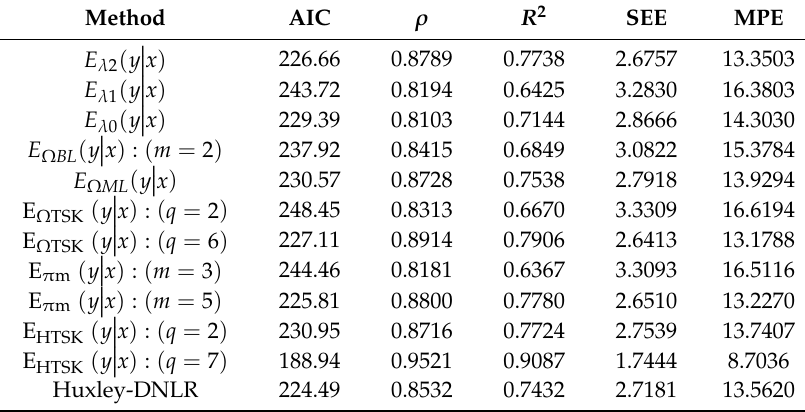
Figure 8. Retransformed biphasic Ω TSK ( u ) (panel ( a )), direct scales fitted biphasic H TSK ( x ) (panel ( b )), Figure 8. Retransformed biphasic 𝛺 (cid:3021)(cid:3020)(cid:3012) (𝑢) (panel ( a )), direct scales fitted biphasic Η (cid:2904)(cid:2903)(cid:2895) (𝑥) (panel Huxley’s model of simple allometry (panel ( c )) and curvature index κ ( x ) (panel ( d )). Deviations of ( b )), Huxley’s model of simple allometry (panel ( c )) and curvature index 𝜅(𝑥) (panel ( d )). Deviations (cid:12) (cid:12) fitted Huxley’s power function relative to E H TSK ( y (cid:12) x ) in panel c) explain deviations of κ ( x ) from line of fitted Huxley’s power function relative to 𝐸 (cid:2943)(cid:3021)(cid:3020)(cid:3012) (𝑦|𝑥) in panel c) explain deviations of 𝜅(𝑥) from y = 1 shown in panel ( d ). line 𝑦 = 1 shown in panel ( d ). Table 4. Performance metrics for arithmetical space proxies identified from the Ramirez-Ramirez et al. Table 4. Performance metrics for arithmetical space proxies identified from the Ramirez-Ramirez et [6] ABG-H data set. We include retransformed forms of λ m ( u ) : ( m = 0, 1, 2) and Ω BL ( u ) : (biphasic)) al. [6] ABG-H data set. We include retransformed forms of 𝜆 (cid:3040) (𝑢): ( 𝑚 = 0, 1, 2 ) and Ω (cid:2886)(cid:2896) (𝑢) ∶ π Ω ( u ) (biphasic) and Ω ( u ) ( q = 2, 6) and compare to compared to Huxley’s m ( u ) : ( m = 3, 5), ML TSK (biphasic)) 𝜋 (cid:3040) (𝑢): ( 𝑚 = 3, 5 ), 𝛺 (cid:3014)(cid:3013) (𝑢) (biphasic) and 𝛺 (cid:3021)(cid:3020)(cid:3012) (𝑢) ( 𝑞 = 2, 6 ) and compare to compared formula of simple allometry and directly fitted H TSK ( x ) : ( q = 2, q = 7 ) . AIC stands for Akaike’s to Huxley’s formula of simple allometry and directly fitted 𝛨 (cid:3021)(cid:3020)(cid:3012) (𝑥) ∶ (𝑞 = 2, 𝑞 = 7) . AIC stands for information criterion, ρ symbolizes Lin’s concordance correlation coe ffi cient, R 2 denotes determination Akaike’s information criterion, 𝛒 symbolizes Lin’s concordance correlation coefficient, R 2 denotes coe ffi cient, SEE standard error of estimation and MPE mean prediction determination coefficient, SEE standard error of estimation and MPE mean prediction error.